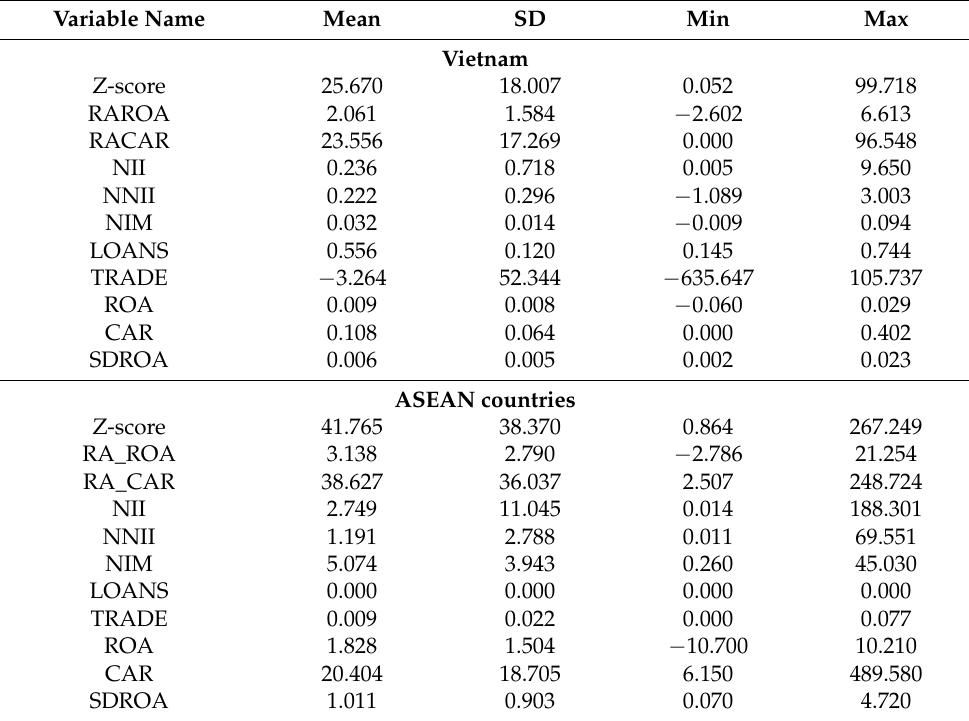
Table 3. Descriptive statistics for Vietnam and ASEAN countries.